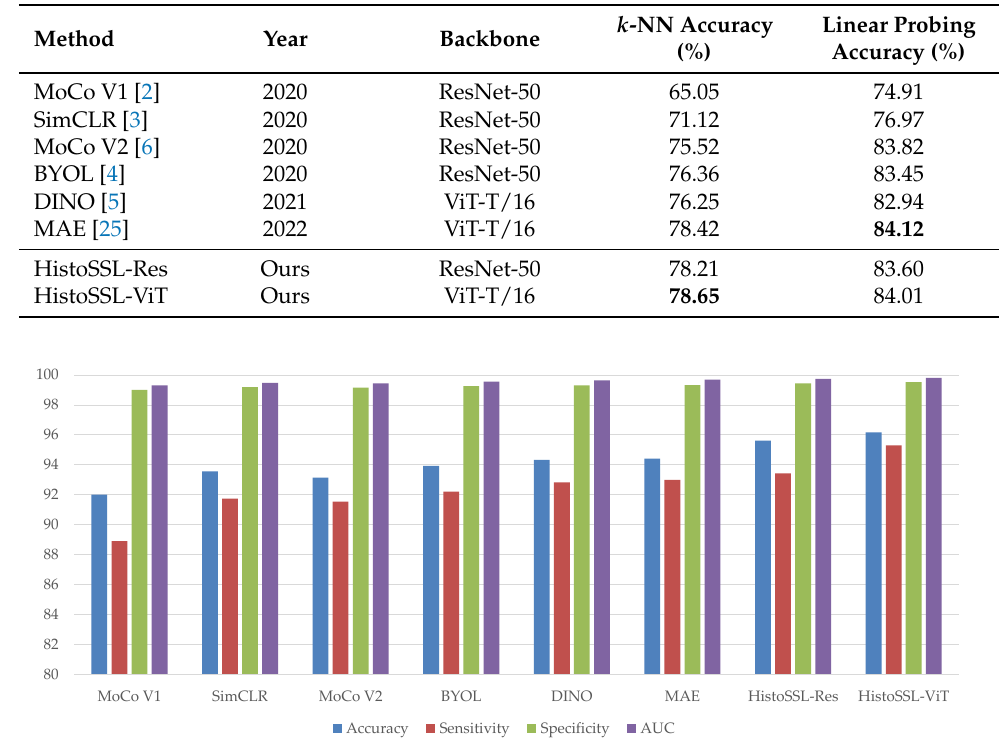
Table 6. Comparing our proposed method with the state-of-the-art frameworks on breast cancer metastasis recognition using the CAMELYON16 dataset.